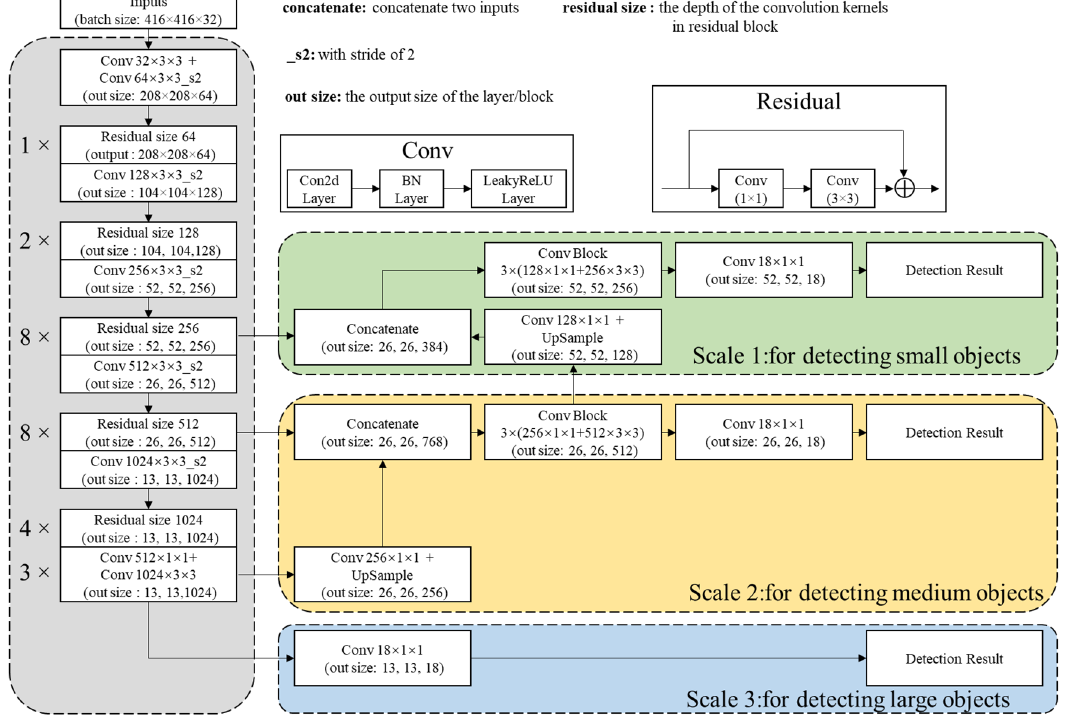
Figure 2. YOLOv3 detection architecture.